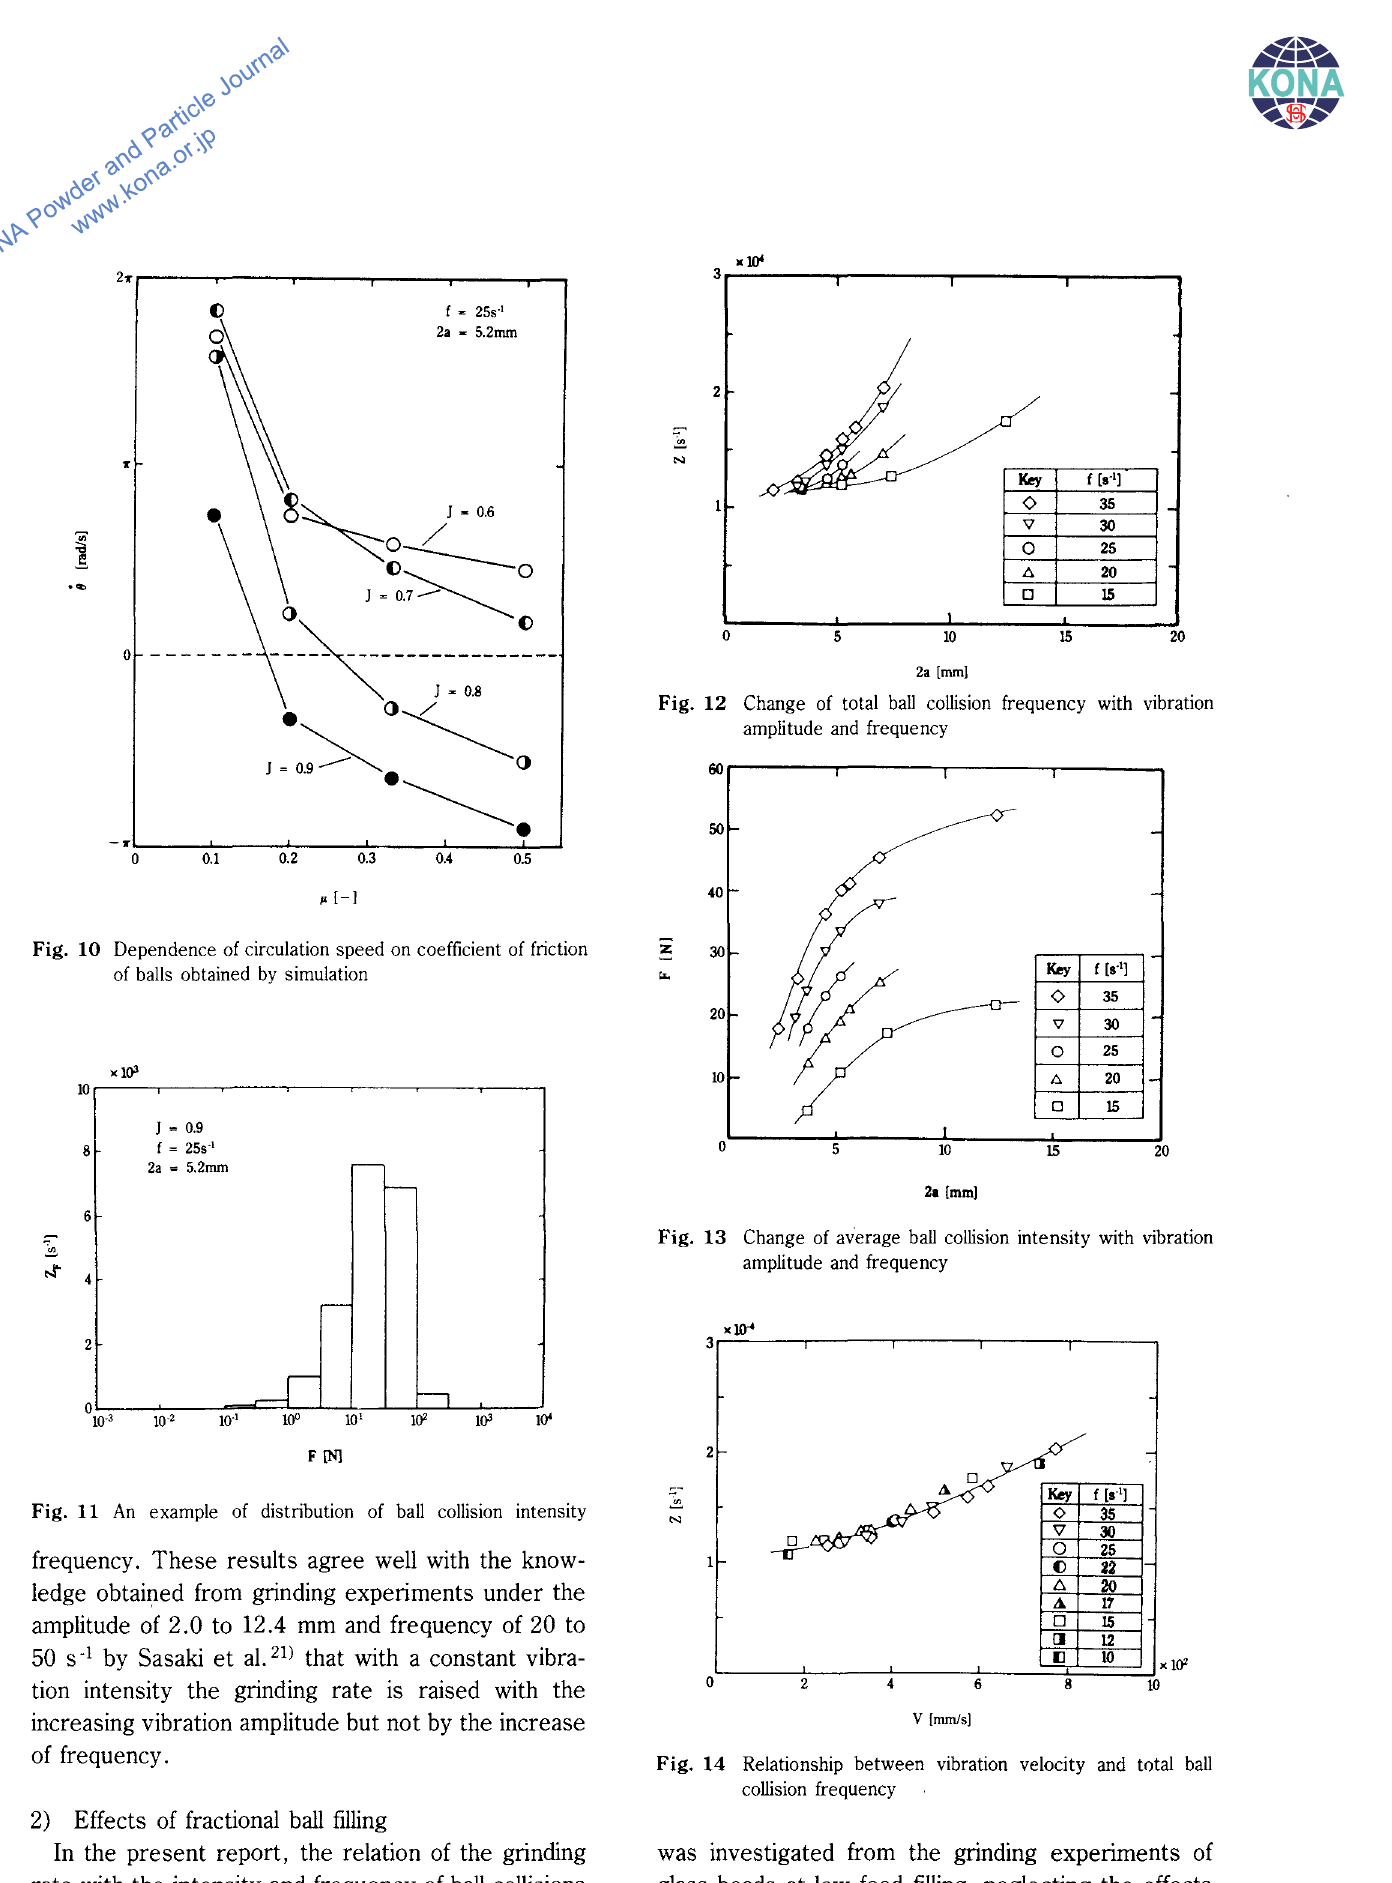
Fig. 14 Relationship between vibration velocity and total ball collision